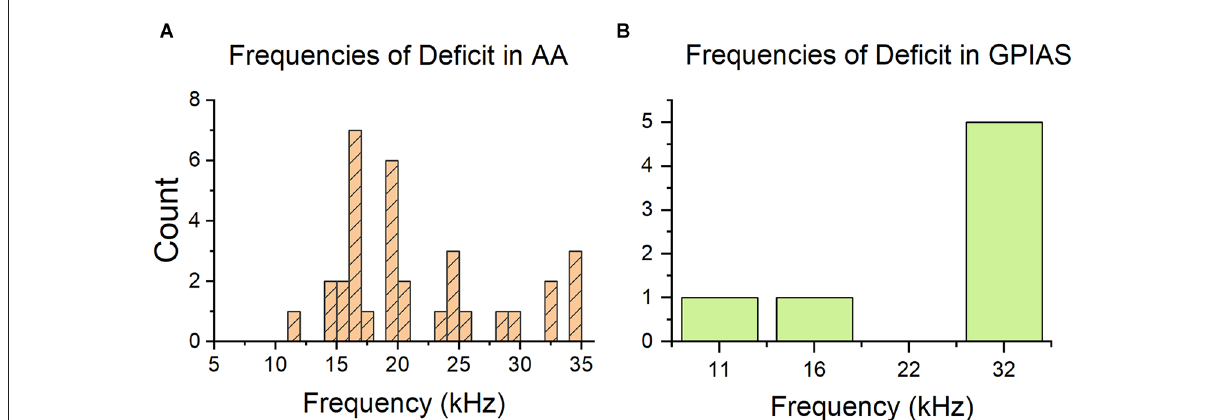
FIGURE4 Distribution of tinnitus frequencies is different between behavior tests. (A) Histogram of frequencies indicated as tinnitus frequencies by the AA test. The count is calculated across all training paradigms. Most of the frequencies are at or above 16 kHz, which is the exposure frequency. (B) Histogram of frequencies of deficit indicated by the GPIAS test. Most frequencies are at 32 kHz, which is not consistent with the AA graph. GPIAS n = 7 frequencies and n = 7 mice, AA n = 33 frequencies and n = 21 animals.